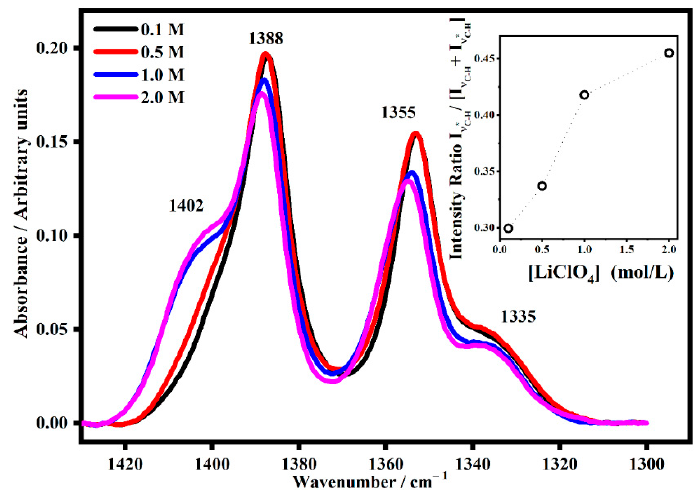
Figure 8. The IR band assigned to the CH 2 wagging mode denominated ν C-H (~1388 cm − 1 ) and its satellite band at ν C-H* (~1402 cm − 1 ) in PMMA-Li-PC gel polymer electrolyte at different salt concentrations: 0.1 M, 0.5 M, 1 M and 2 M. In the inset, the trend of the intensity ratio I ν C-H* /[I ν C-H + I ν C-H* ] as a function of the salt concentrations.